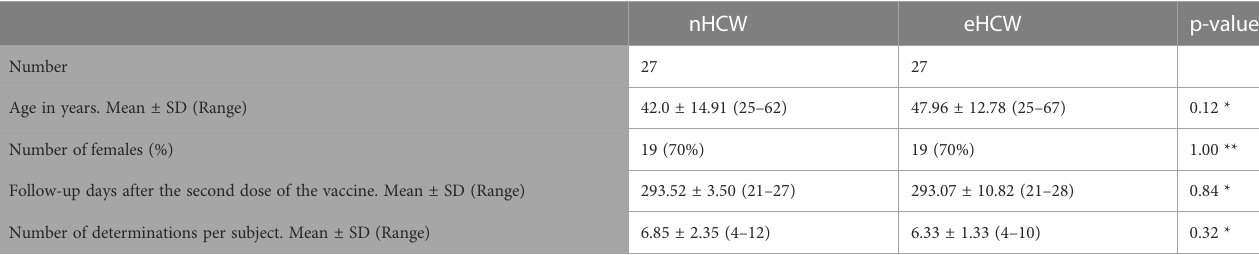
TABLE 1 Demographic characteristics of the participants in the study: * U-Mann-Whitney test; ** Chi Square